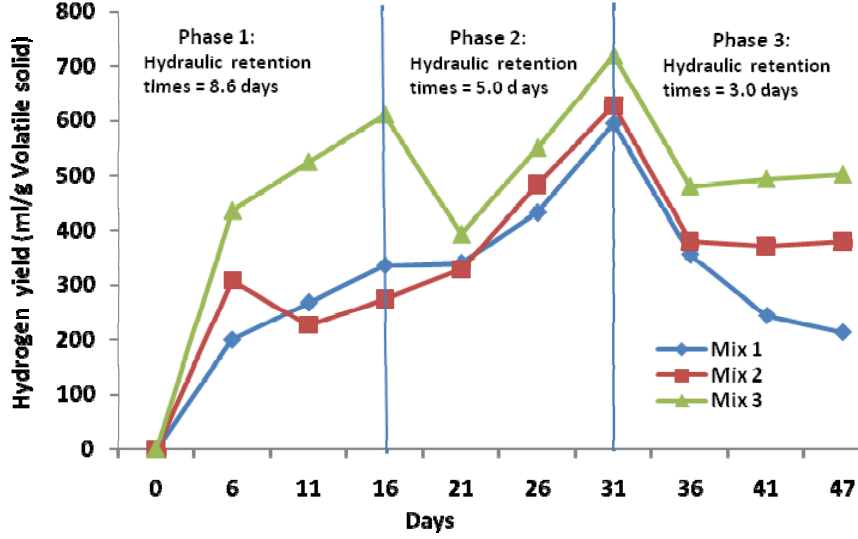
Figure 2. Hydrogen yields from the fermentation of mixed